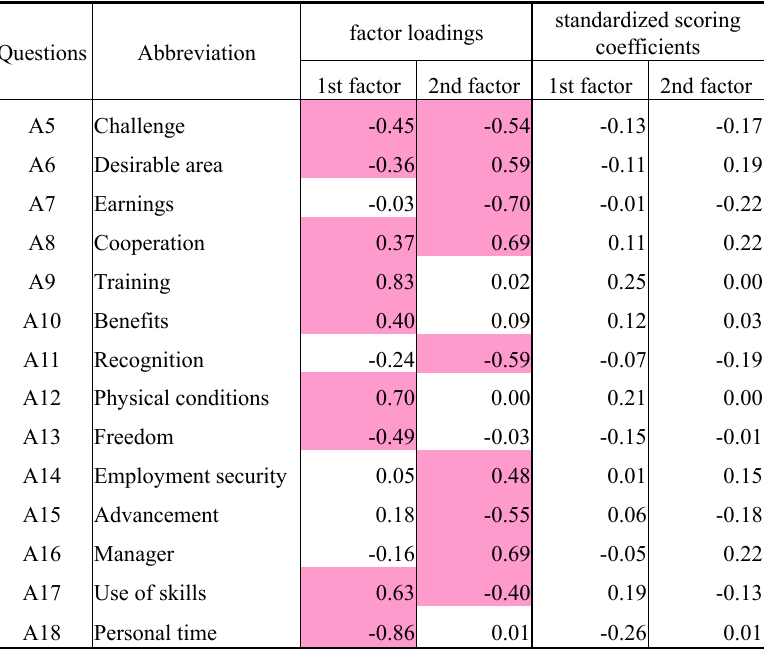
Table 2. Factor Loadings and Standardized Scoring Coefficients of “Work Goals”